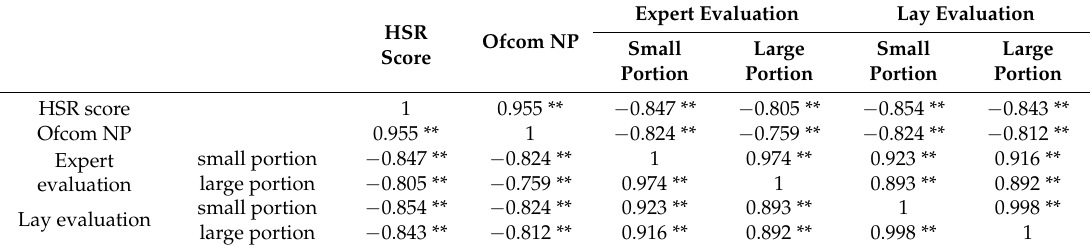
Table 2. Spearman correlations between expert and lay evaluations and Ofcom nutrient profile (Ofcom NP) score and Health Star Rating (HSR) scores. Experts and lay participants evaluated 20 snacks in two portion sizes (small and large) on a scale ranging from 0 (not nutritious) to 100 (very nutritious). The Ofcom NP ranged from − 9 (carrots) to 23 (chocolate). The HSR ranged from − 12 (carrots) to 31 (chocolate). A cut-off for less healthy food was previously set at >4 for the Ofcom NP score [17].